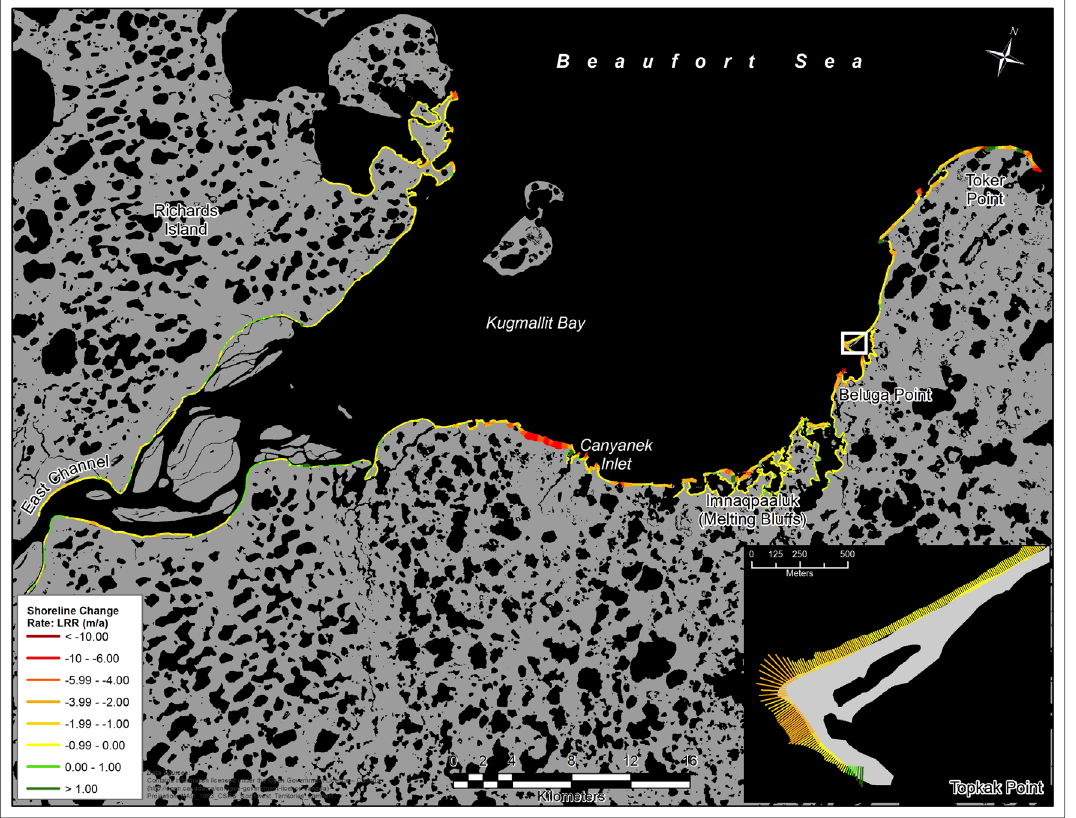
Fig 4: Model of historical shoreline change in the Kugmallit Bay study area. Following the 2013 field season, shoreline change rate calculations for the Toker Point area were bolstered by the inclusion of a fourth shoreline position. Using the methods previously outlined, the 2009 GeoEye-1 imagery was digitized and a new set of LRR-based shoreline trends were calculated. This revised model yielded average LRR values of -1.46 m/a for the Toker Point area overall, -3.70 m/a for the eastern extent of the region, and -4.27 m/a for the 10 transects closest to the monitoring stakes (Fig. 7). The persistence of this historical erosion rate into recent years can be seen in the Figure 7 inset map. The position of the 2m stake placed in 2013 is roughly 17 m from the active shoreline visible in the 2009 imagery, indicating an average annual loss of 4.25 m/a over four years at that shoreline position.